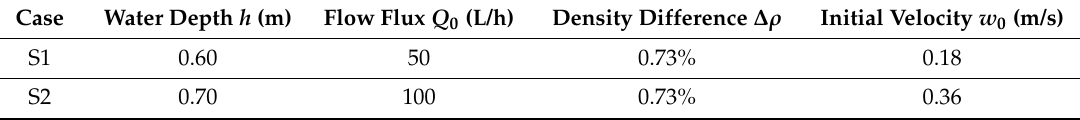
Table 2. Experimental cases of buoyant jet in the still water